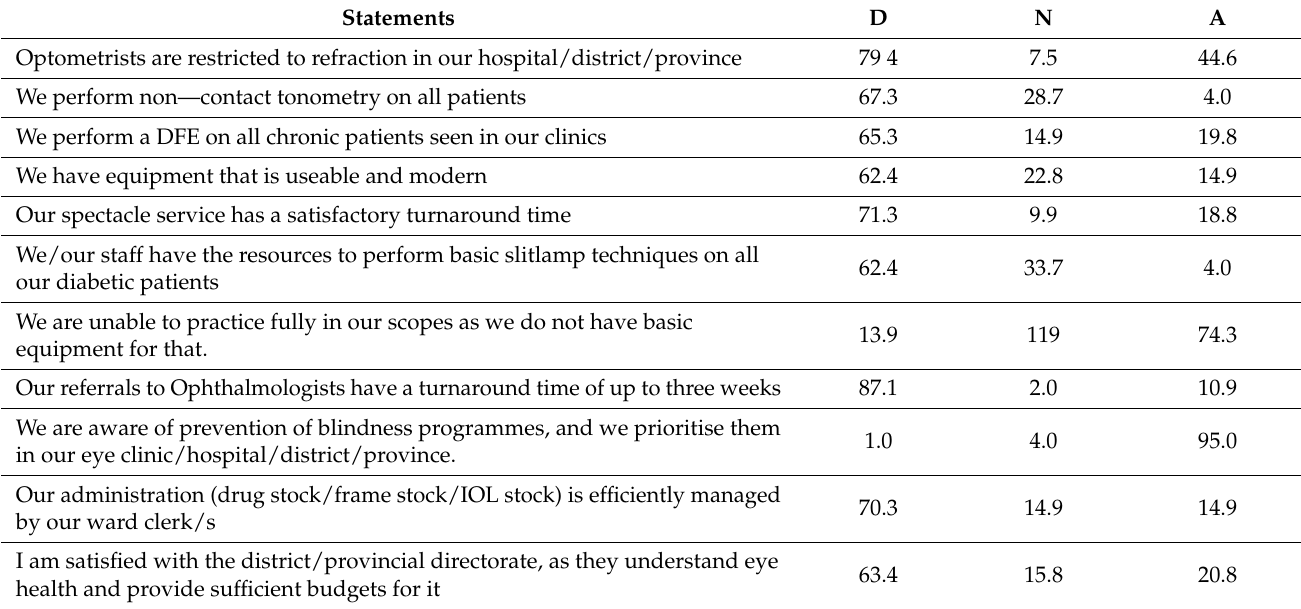
Table 5. Practices towards eye health by eye health workers (%).